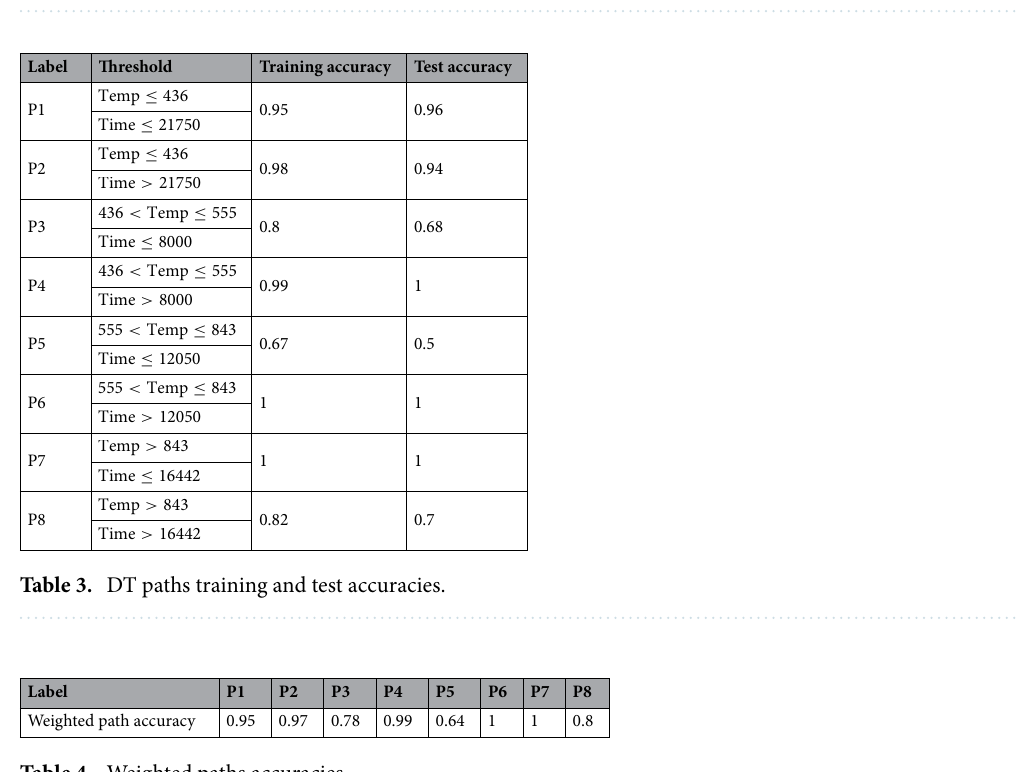
Figure 3. Four layers of the selected model DT.